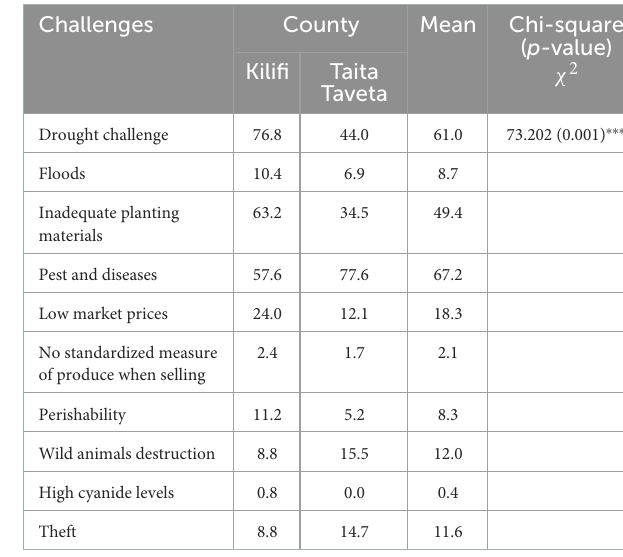
TABLE 2 Challenges facing cassava production in Kilifi and Taita Taveta